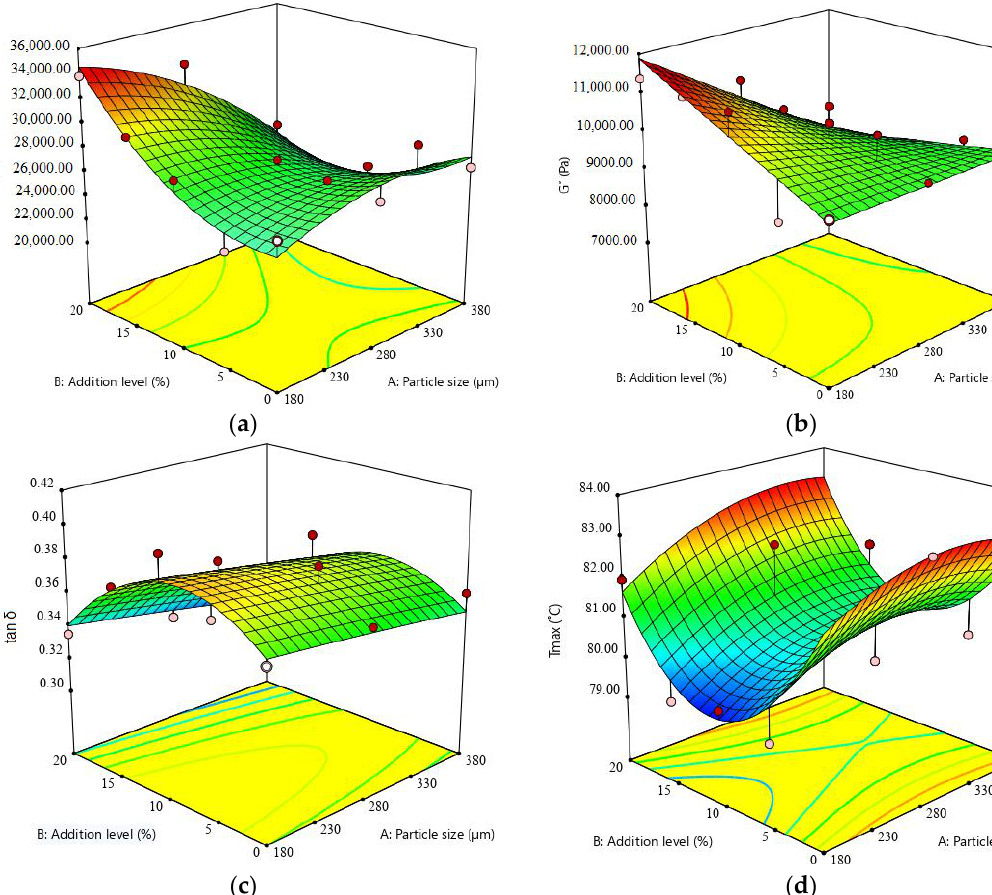
Figure 5. Response surface graphic of ( a ) storage modulus ( G′ ), ( b ) loss modulus ( G″ ), ( c ) loss tangent (tan δ), and ( d ) maximum gelatinization temperature (T max ) as a function of buckwheat flour fractions and addition level.